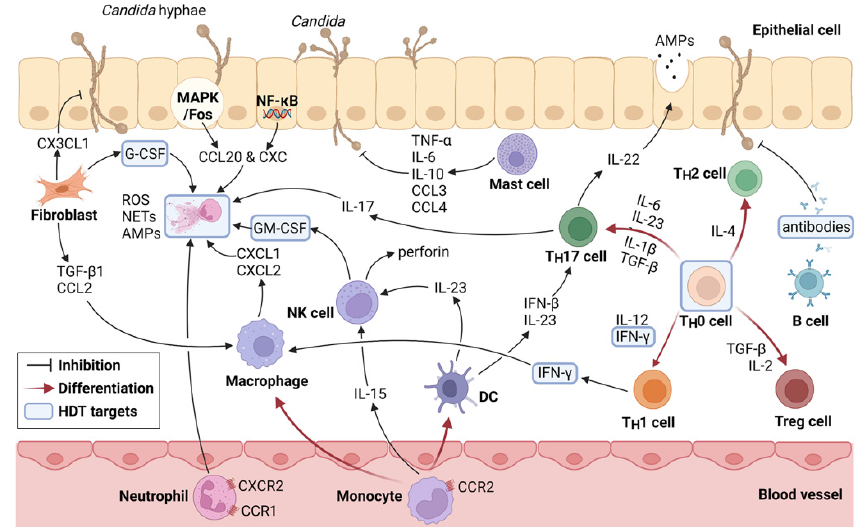
Figure 2. Mechanisms against Candida involving innate and adaptive immunity. Host cells play an anti- Candida role directly by secreting cytokines with antifungal activities, such as AMPs secreted by epithelial cells, CX3CL1 secreted by fibroblasts, and IL-6 secreted by MCs. In addition, antifungal cytokines also include perforin secreted by NK cells, IL-22 produced by T H 17 cells, antibodies produced by B cells, etc. Additionally, host cells play the antifungal role indirectly by the recruitment of immune cells or via affecting the differentiation and activation of immune cells. Some cells and cytokines mentioned above have become targets of the current HDTs of Candida . AMPs, antimicrobial peptides; CX3CL1, C-X3-C motif chemokine ligand 1; TGF- β 1, transforming growth factor beta1; G-CSF, granulocyte-colony stimulating factor; CCL, C-C motif chemokine ligand; MCs, mast cells; TNF- α , tumor necrosis factor alpha; CXCR, C-X-C chemokine receptors; CCR, CC Chemokine receptor; GM-CSF, granulocyte macrophage colony-stimulating factor; CXCL, C-X-C motif ligand; NK cells, natural killer cells; ROS, reactive oxygen species; NETs, neutrophil extracellular traps; HDT, host-directed therapy.